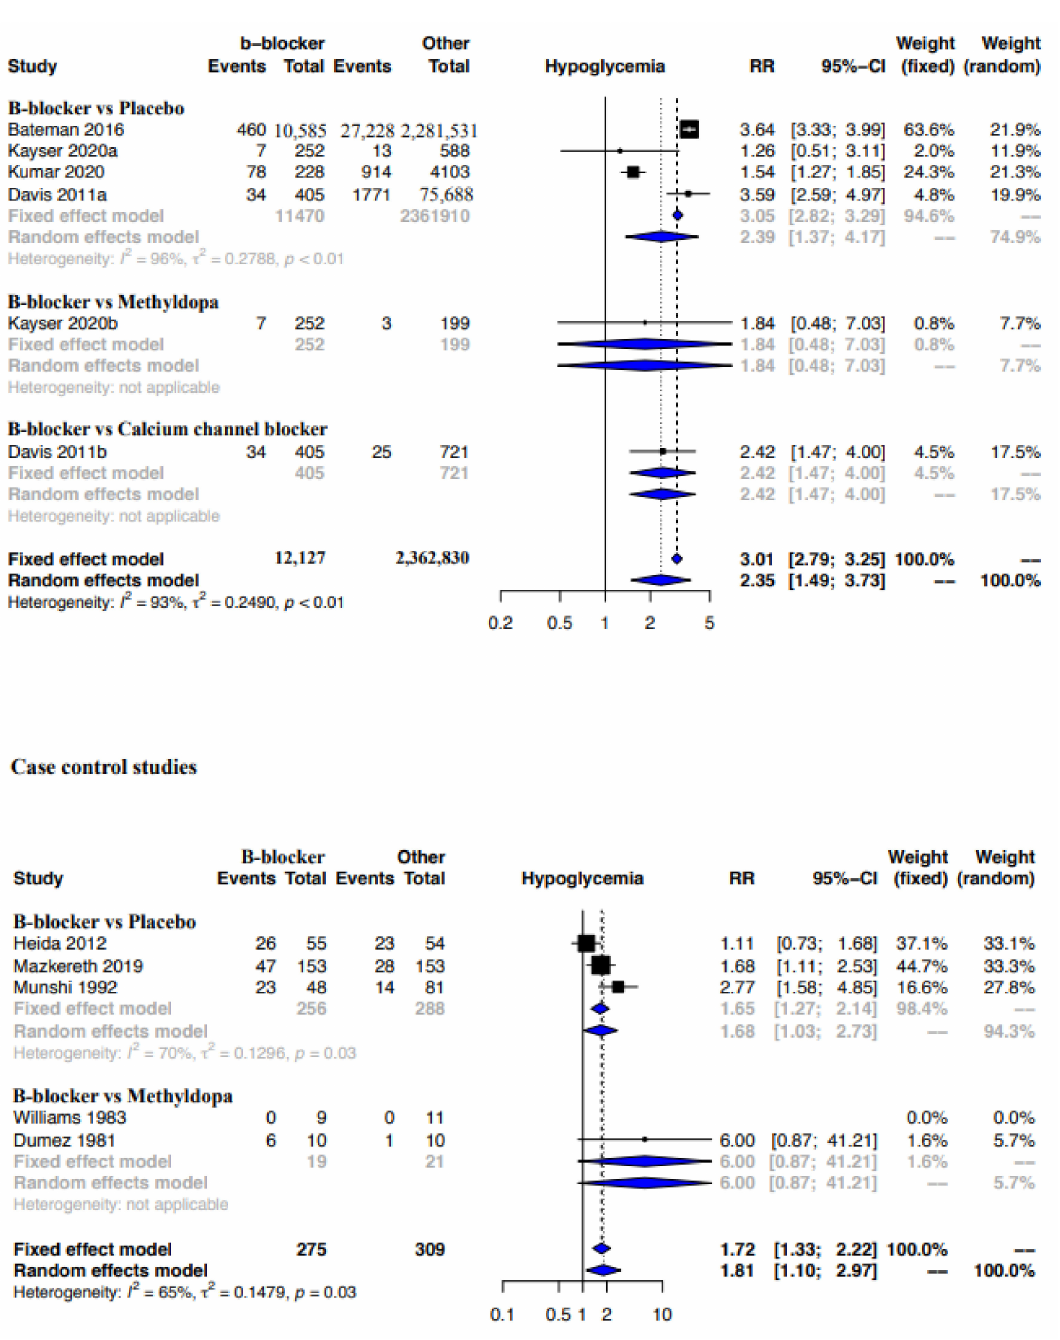
Figure 6. Meta-analysis hypoglycemia—Cohort and case–control studies. Cohort studies: beta- blockers vs. placebo: [30,31,35,39]; beta-blockers vs. methyldopa: [30]; beta-blockers vs. calcium channel blocker: [39]. Case control studies: beta-blocker vs. placebo: [32,37,43]; beta-blockers vs. methyldopa: